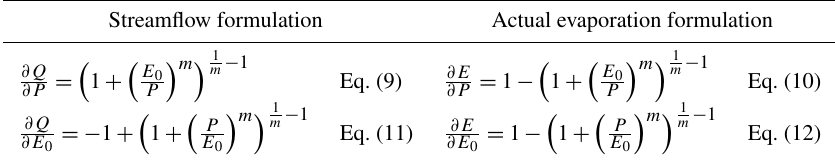
Table 3. Partial derivatives of the Tixeront–Fu formula ( P – precipitation, Q – streamflow, E 0 – maximum evaporation, E – actual evapora- tion, all in mmyr − 1 averaged over many years). m is the free parameter of the Tixeront–Fu formula ( m >